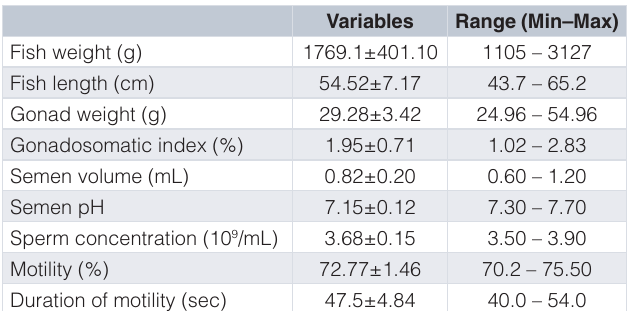
Table 2. Male size and sperm characteristics of Hemibagrus wyckii (Mean ± SD).